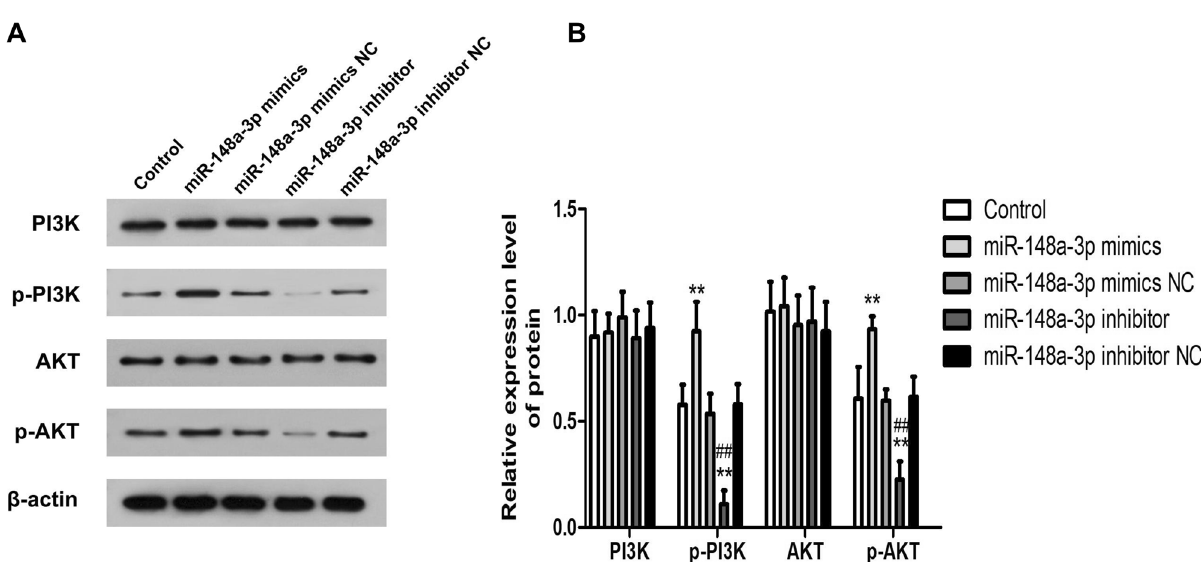
Figure 9. Protein expression level of PI3K/Akt signaling pathway-related proteins in hippocampal neurons of rats. ( A ) protein bands of PI3K/Akt signaling pathway-related proteins detected by western blotting ( B ) Comparison on expression of PI3K/Akt signaling pathway-related proteins. **P < 0.01 compared with the control group; ## P < 0.01 compared with the miR-148a-3p mimics group. PI3K hosphatidylinositol 3-kinase, p-PI3K phosphorylated PI3K, p-Akt phosphorylated